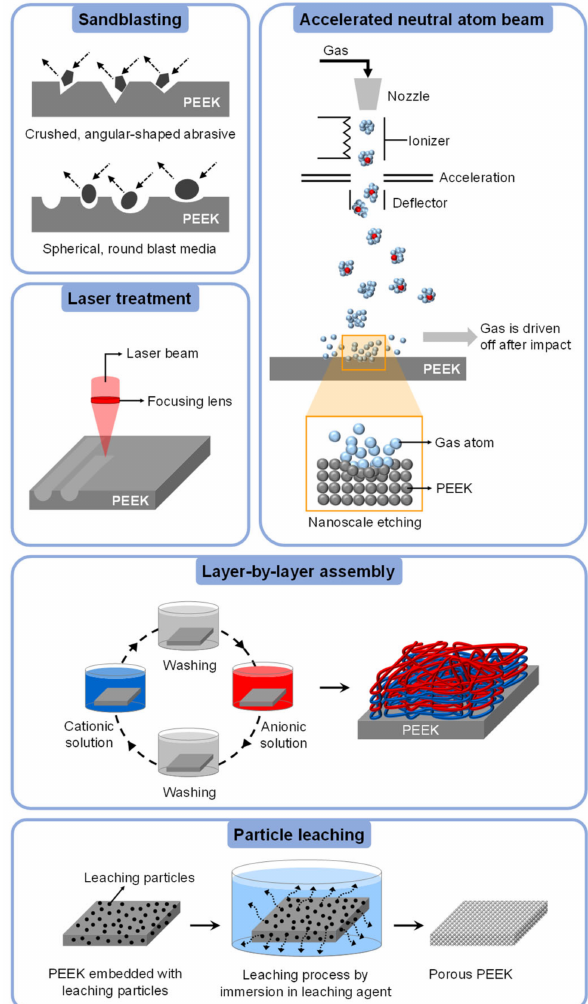
Figure 10. Illustration of physical surface modifications of PEEK. The figure of the accelerated neutral atom beam is inspired by previously published literature